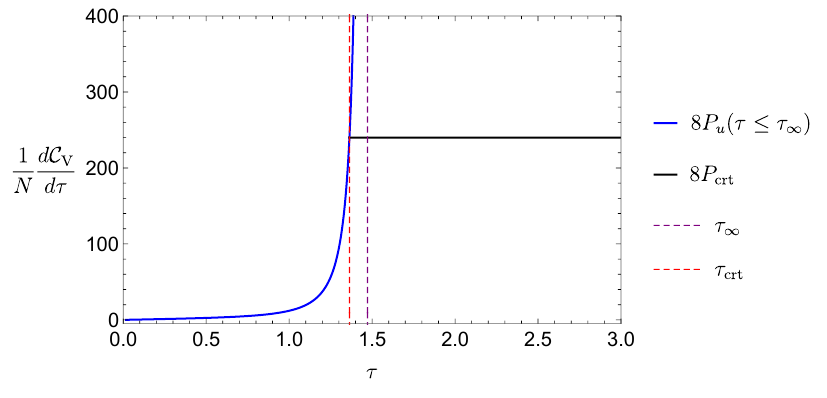
Figure 13 . The time derivative of holographic complexity d C V ( τ ) . The blue curve is referred to dτ as the growth rate before the critical time, i.e., P u ( τ ≤ τ ∞ ) . After introducing the cut-off surface, holographic complexity C ( τ ≥ τ crt ) grows linearly with a growth rate 8 NP crt as indicated by the V black line. We choose d = 2 , ρ = 9 , ε = 1 for this 10 10